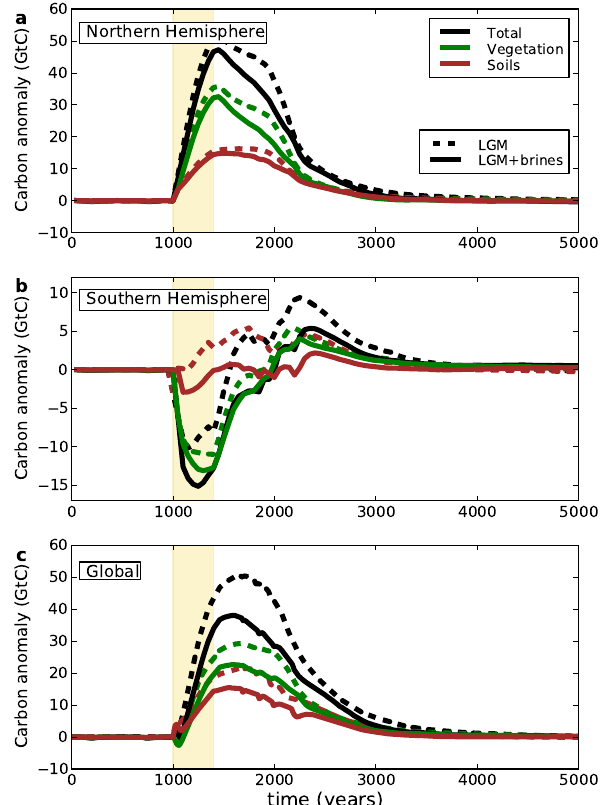
Fig. 14. Evolution of the carbon content anomaly in the terres- trial biosphere (GtC) (a) in the Northern Hemisphere, (b) in the Southern Hemisphere and (c) total of the two hemispheres. The total carbon in the terrestrial biosphere (black) is decomposed in its two subreservoirs: the vegetation (green) and soils (brown). In the simulation the fresh water flux added into the North Atlantic has an amplitude of 0.5Sv during 400 yr. Two background climate states are considered: the Last Glacial Maximum (LGM, dashed lines) and the Last Glacial Maximum with the sinking of brines (LGM+brines, solid